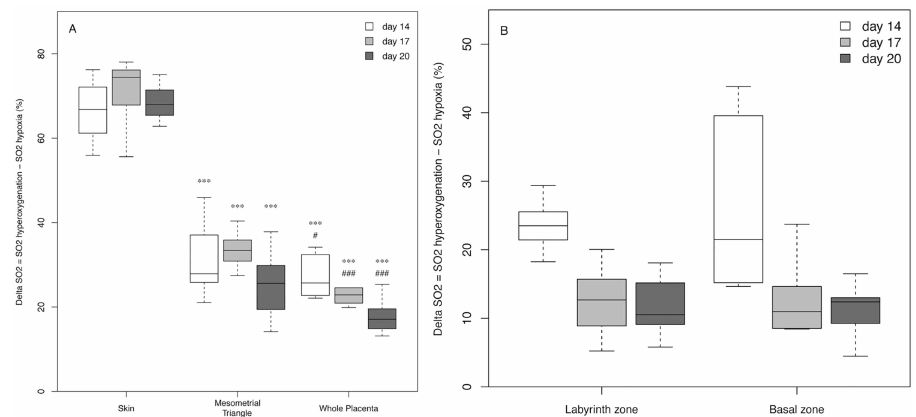
Fig 4. Box-and-whisker plot showing Δ O 2 corresponded to the mean change in oxygen saturation between hyperoxygenated (100% oxygen supplied to mother) and hypoxic (5% oxygen supplied) saturation. (A) Representsmaternalskin, the mesometrial triangle, and the whole placentaon different days of gestation. (B) Box-and-whisker plot represents the different part of the placenta : the basal zone and the labyrinth zone on different days of gestation. Data are mean values and 95% confidenceintervals. Comparisons betweenskin and utero-placental regions of interest (mesometrial triangleand wholeplacenta) at the same day of gestationare indicatedby * P = 0.05 ** P = 0.01 *** P < 0.001. Comparisons between mesometrial triangleand whole placentaat the same day of gestation are indicatedby #P = 0.05 ## P = 0.01 ###P <